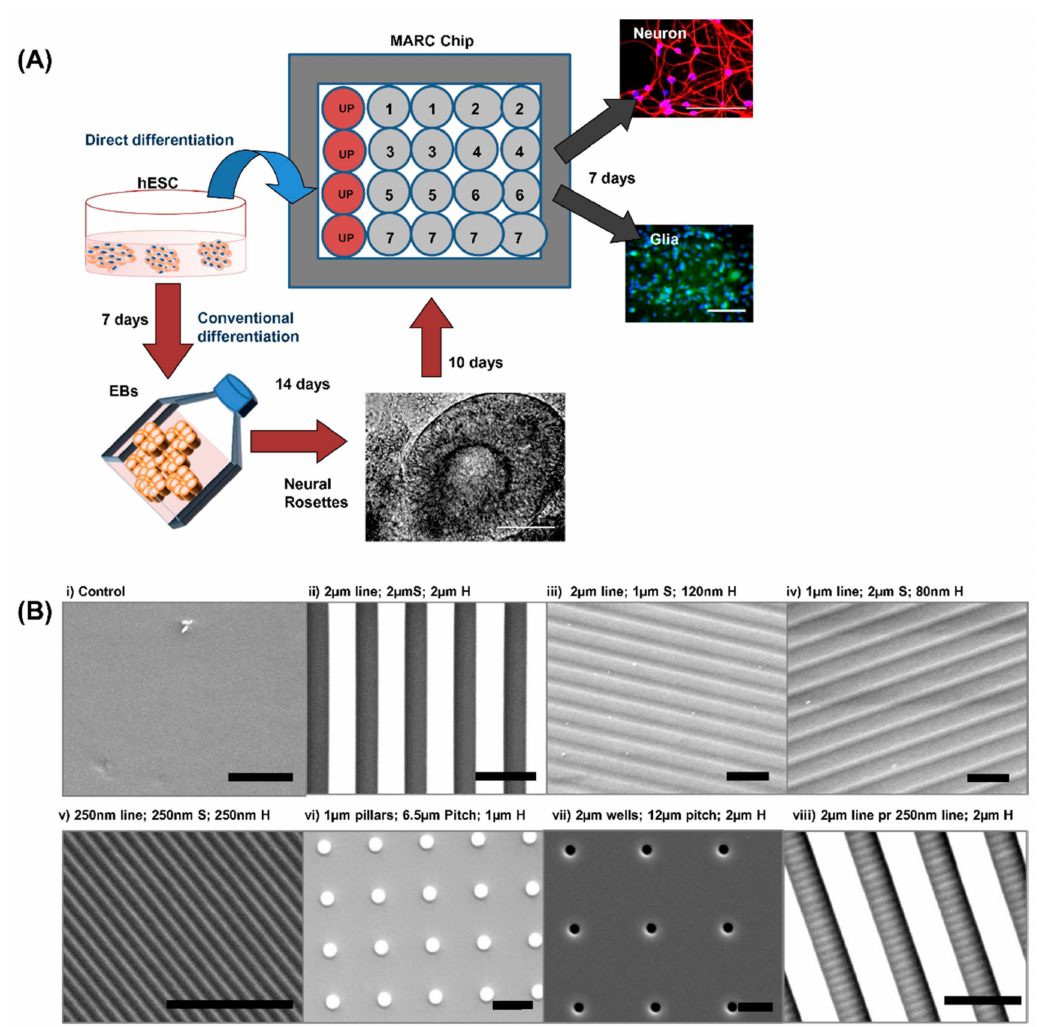
Figure 4. ( A ) A schematic of human embryonic stem cell (hESC) neural differentiation into neurons and glial cells on the multi-architecture chip (MARC) with minimal neuronal supplements by the direct or conventional method. In “direct differentiation” (blue arrow), the hESCs were seeded directly on the MARC and analyzed for neural markers after 7 days. In “conventional methods” (red arrows) of differentiation, hESCs were grown as embryoid bodies and neurospheres before seeding onto the MARC. On the MARC, each pattern is represented by a circle and has a duplicate. The red circles represent the unpatterned control surface. Scale bar: 100 µ m. ( B ) ( i – viii ) Patterns are replicated with high fidelity on polydimethylsiloxane (PDMS) as verified by scanning electron microscopy (SEM) images. The geometries are transferred onto PDMS from the MARC master molds by soft lithography. ( i ) Unpatterned PDMS control, ( ii ) 2 µ m grating with 2 µ m spacing and 2 µ m height, ( iii ) 2 µ m grating with 1 µ m spacing and 120 nm height, ( iv ) 1 µ m grating with 2 µ m spacing and 80 nm height, ( v ) 250 nm grating with 250 nm spacing and 250 nm height, ( vi ) 1 µ m pillar with 6.5 µ m pitch and 1 µ m height, ( vii ) 2 µ m wells with 12 µ m pitch and 2 µ m height, ( viii ) hierarchical structure having 250 nm gratings with 250 nm space perpendicular to the 2 µ m grating. The spacing and height between the 2 µ m gratings is also 2 µ m. Scale bars: 5 µ m. Abbreviations: “S” refers to the spacing between the gratings, “H” refers to the height of the topography and “perpendicular to” is abbreviated as “pr.” Adapted with permission from Ref.